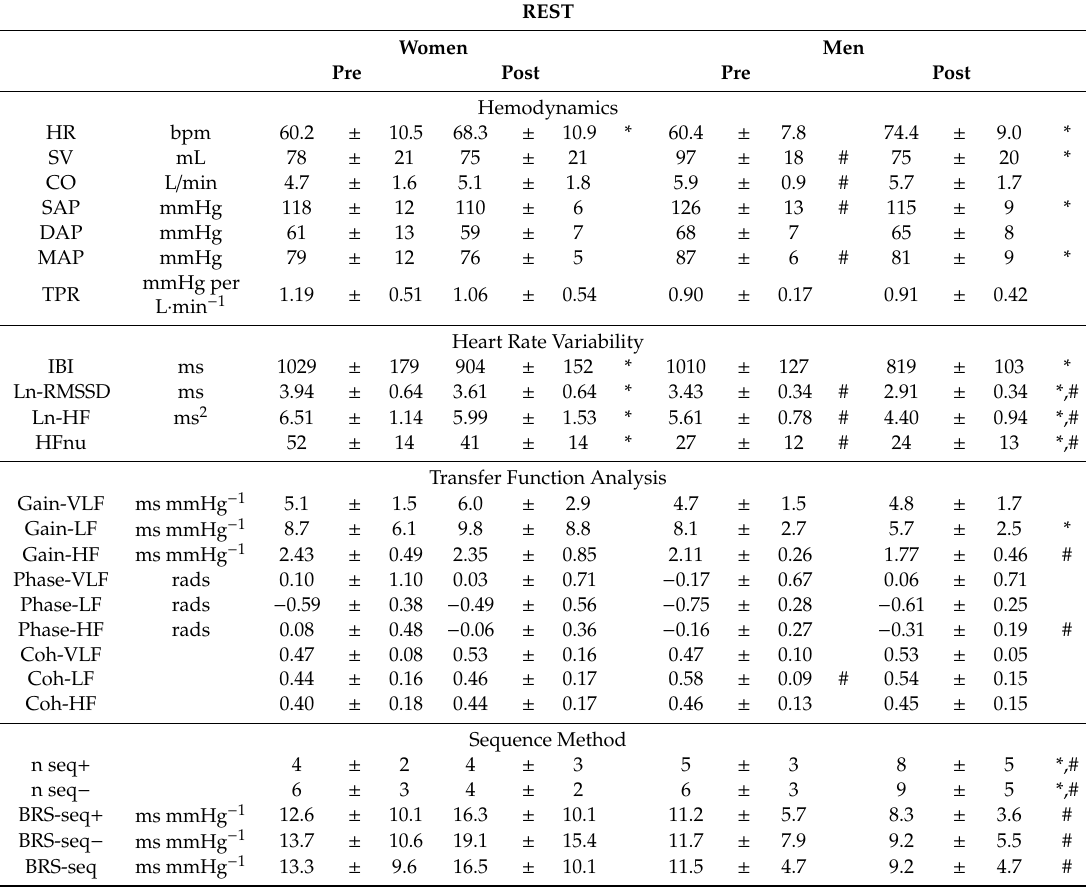
Table 1. Hemodynamic and neuro-hormonal variables before (Pre) and after (Post) the 21-km run in women and men in supine position.